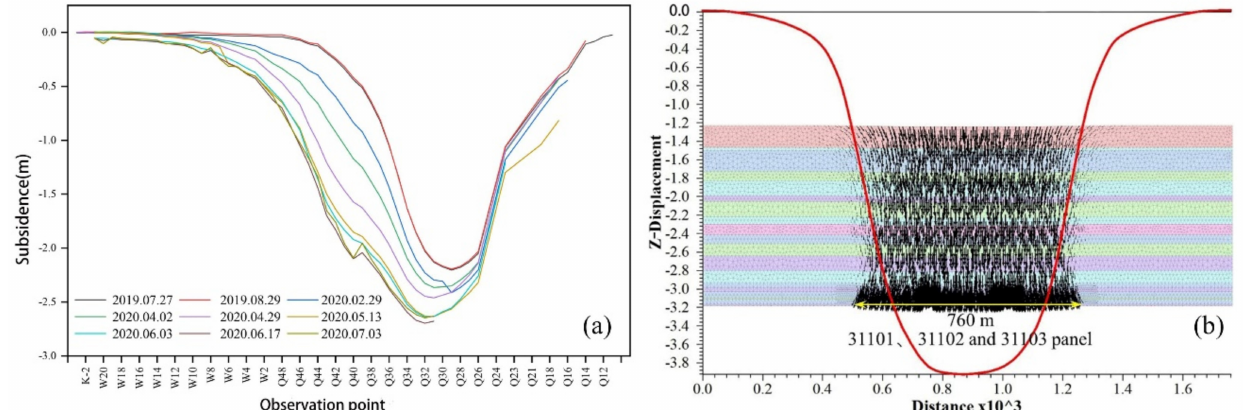
Figure 3. ( a ) Dynamic characteristics of dip surface subsidence curve of the working face (layout of survey line Q–W). ( b ) Prediction results of the settlement numerical